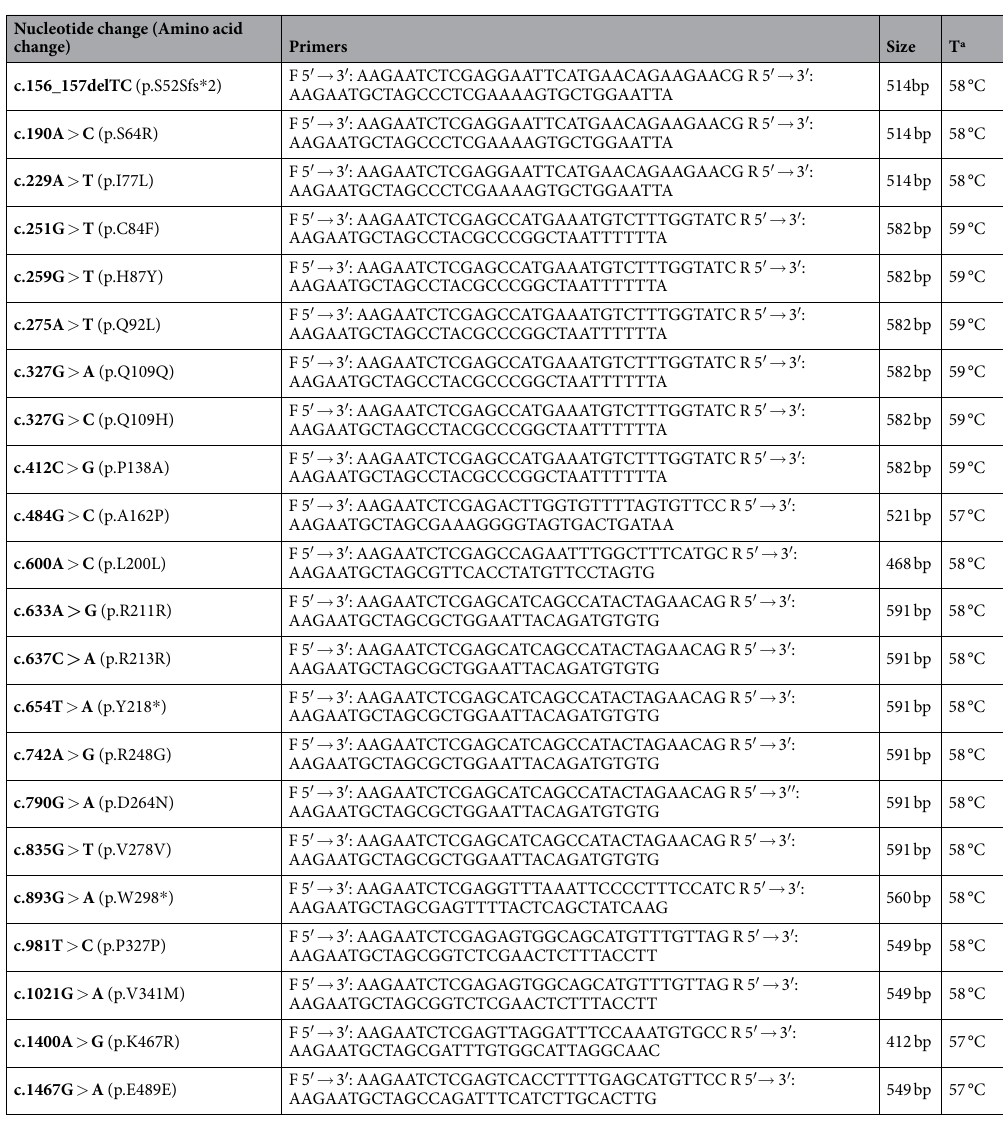
Table 5. Primer sequences for minigene fragments in the BMPR2 gene. F: Forward; R: Reverse. bp: Base